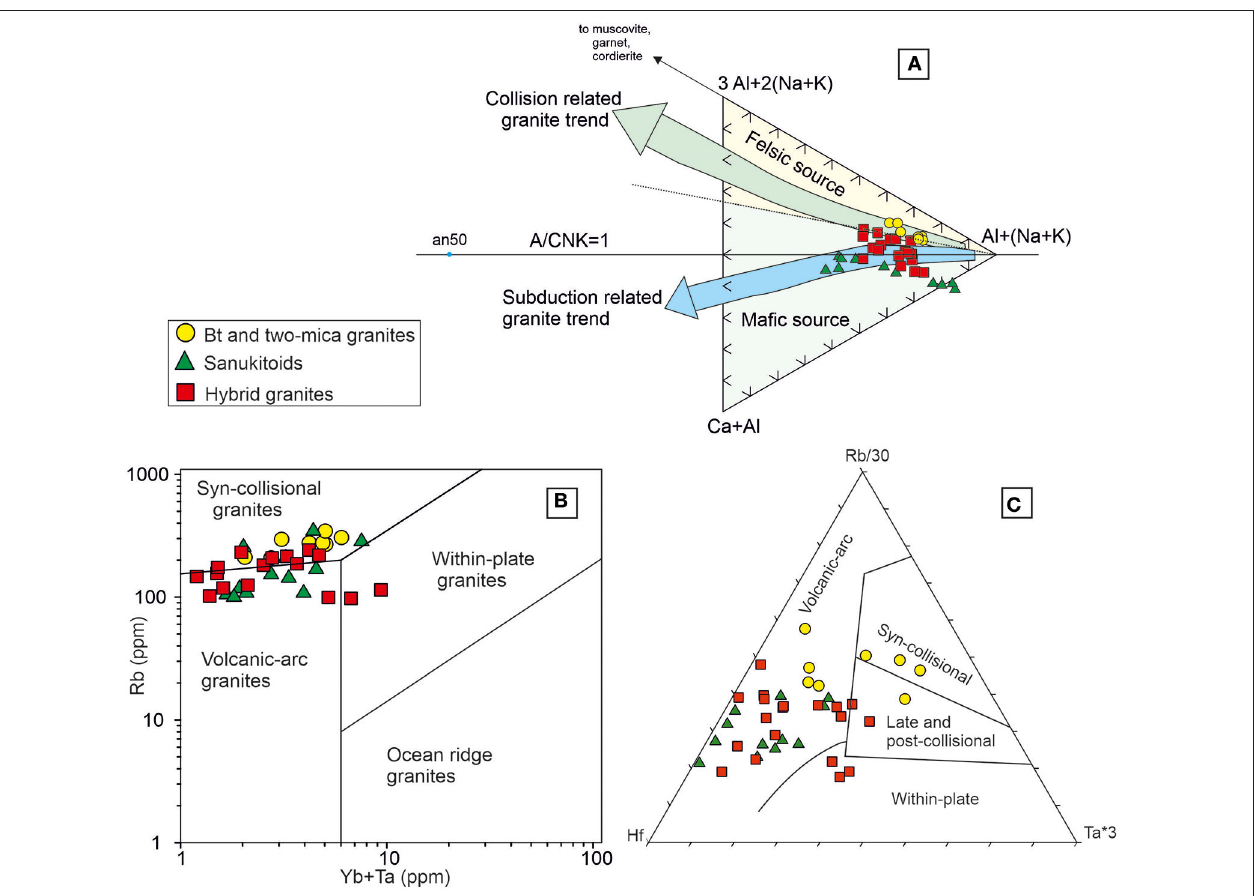
FIGURE 9 | (A) The Ca + Al - 3Al + 2(Na + K) - Al + (Na + K) projection diagram to differentiate the sources and the tectonic setting trends in the evolution of granites ( Moyen et al., 2017; Moyen and Laurent, 2018). The projection has been plotted using the GCDkit (Janoušek et al., 2016). (B,C) are tectonic discrimination diagrams for granites ( Pearce et al., 1984; Harris et al., 1986) suggestive of an arc to collisional origin for the Kanker